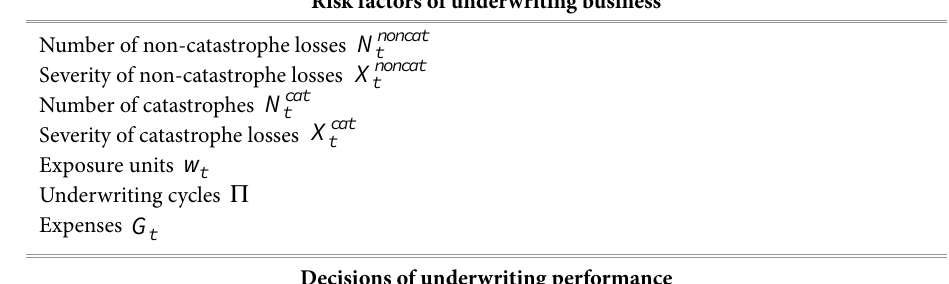
Table 2. Risk factors and decision variables of underwriting activity Risk factors of underwriting